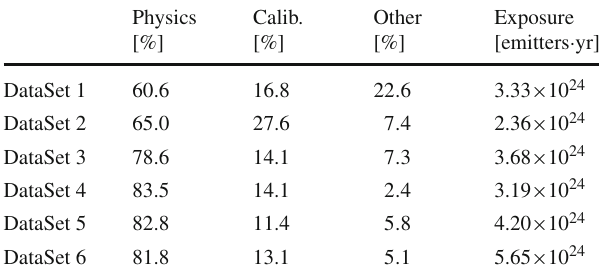
Table 2 Fraction of time that was spent in physics runs, 232 Th, 56 Co and Am-Be calibrations (Calib.) and for tests, liquid helium refills of the cryostat, software debug, DAQ problems (Other). In the last column we report the 82 Se exposure (enriched crystals only) collected in each